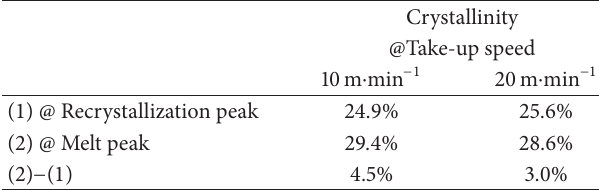
Table 4: Crystallinity of as-spun PET bristles extruded at 20 rpm and different take-up speeds.